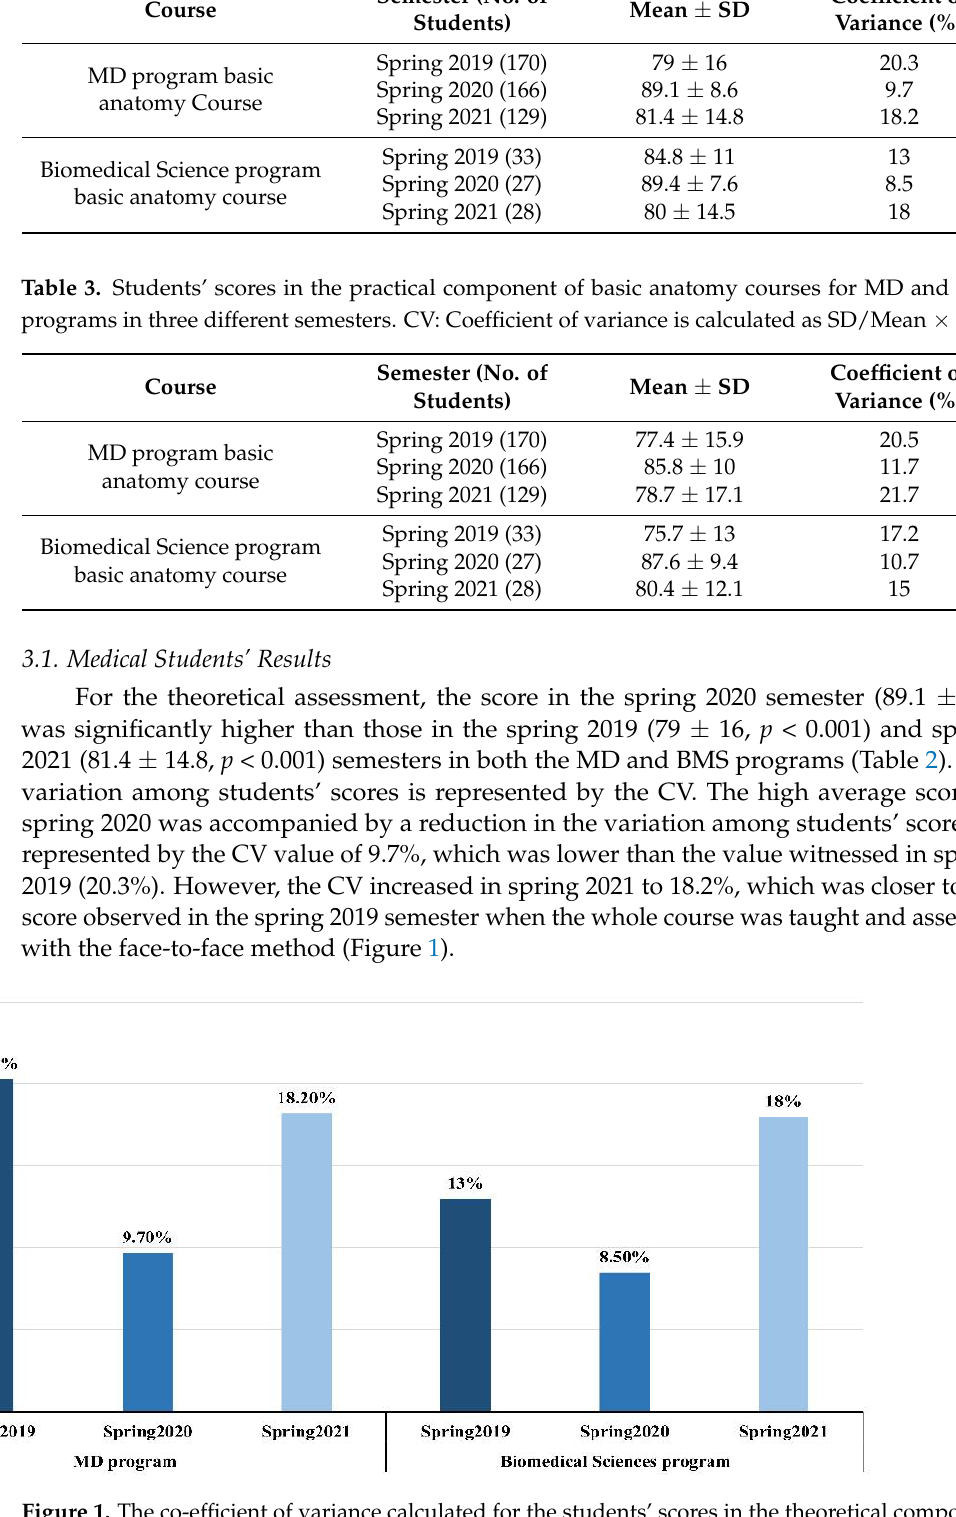
Figure 1. The co-efficient of variance calculated for the students’ scores in the theoretical component of basic anatomy course for MD and biomedical sciences programs in three semesters. CV = SD/Mean × 100.